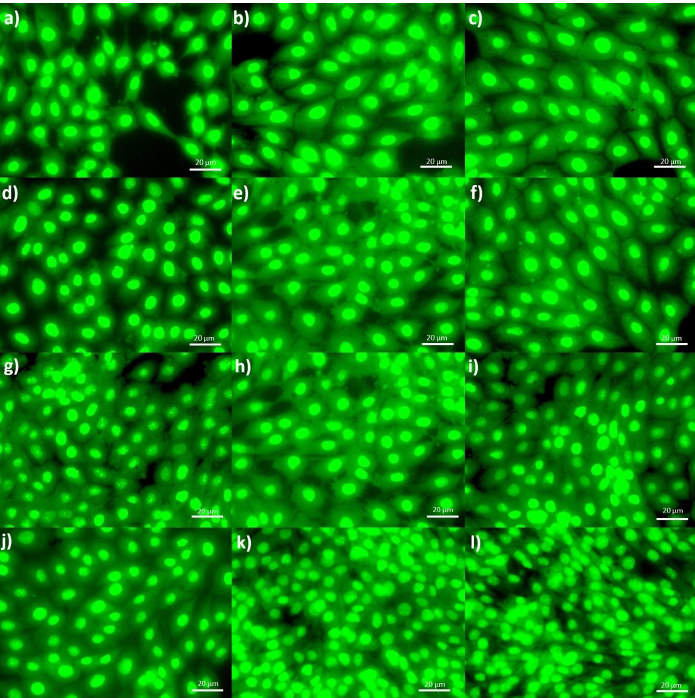
Figure 8. Morphology of HDFn cells stained with AO, grown for 24 ( a – f ) and for 48 h ( g – l ), on C2%, C2.5%, C3%, B2%, B2.5%, and B3% films, consecutively. 4. Conclusions Through the FTIR technique, observing the carbonyl, hydroxyl, and amide functional groups in the chemical structure of chitosan and gelatin present in the composite and bi- layer films was possible due to the presence of the characteristic functional groups of gel- atin and chitosan in all the films analyzed and, in addition, since the observed signals did not show considerable differences between them, the presence of both polymers was ver- ified in all the films, giving, as a result, is an interaction between the two materials. Ac- cording to the images obtained from the SEM, the composite films present a greater thick- ness, with 276 µm, 243.8 µm, and 239 µm compared to 236 µm, 233 µm, and 219 µm thick for bilayer films; and a low degradation rate compared to bilayer films. This is because the accommodation in the bilayer films occurs uniformly. While in the composite films, the gelatin and chitosan molecules collide with each other. In addition, the separation of chi- tosan and gelatin was obtained in the bilayer films, as observed in the SEM images.